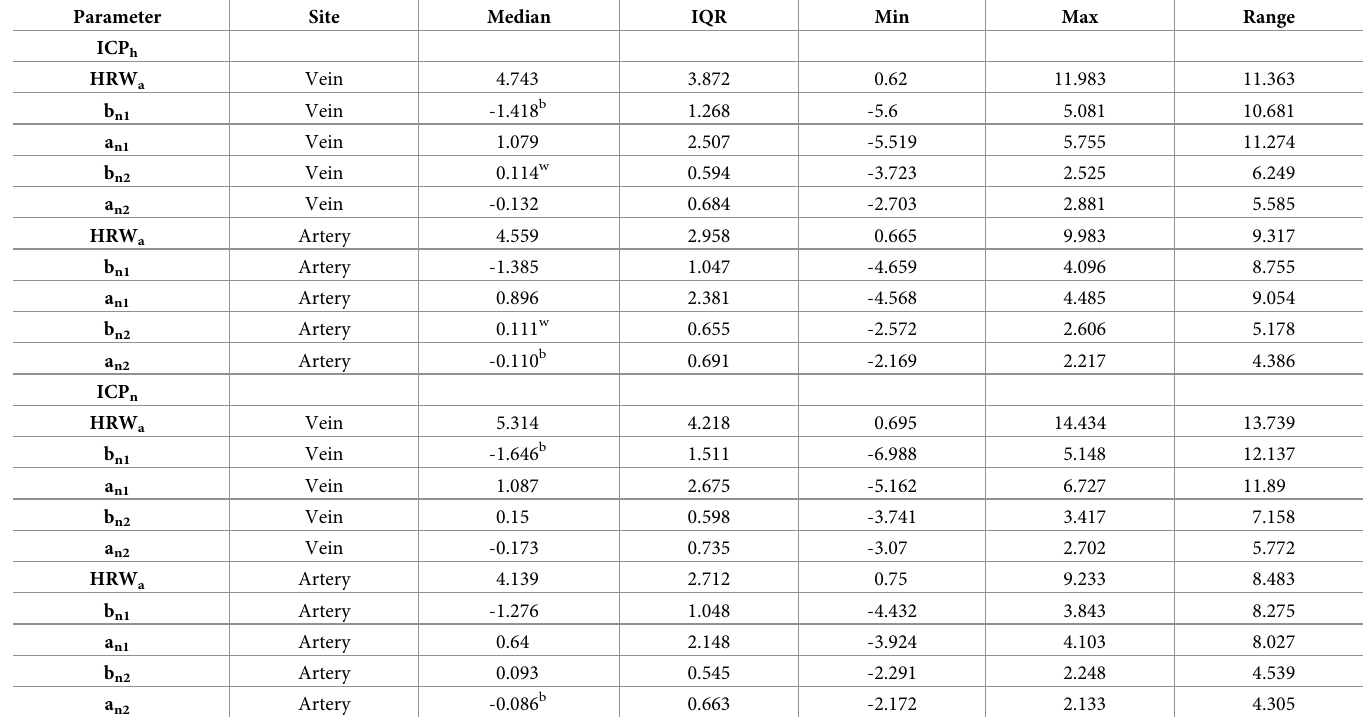
Table 2. Summary descriptive statistics for the high intracranial pressure (ICP h ) and normal intracranial pressure (ICP n ) groups.